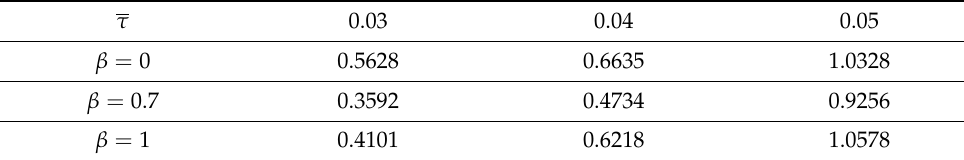
Table 2. Minimum γ for various of τ and β values in Case